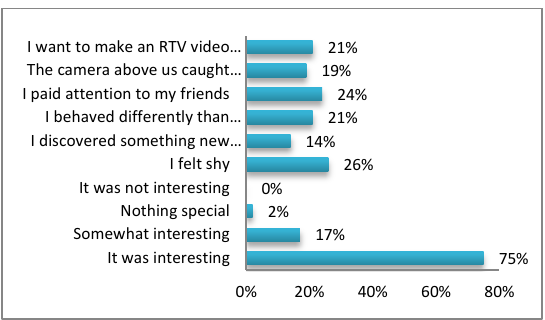
Figure 16 RTV of the game and students' interaction with